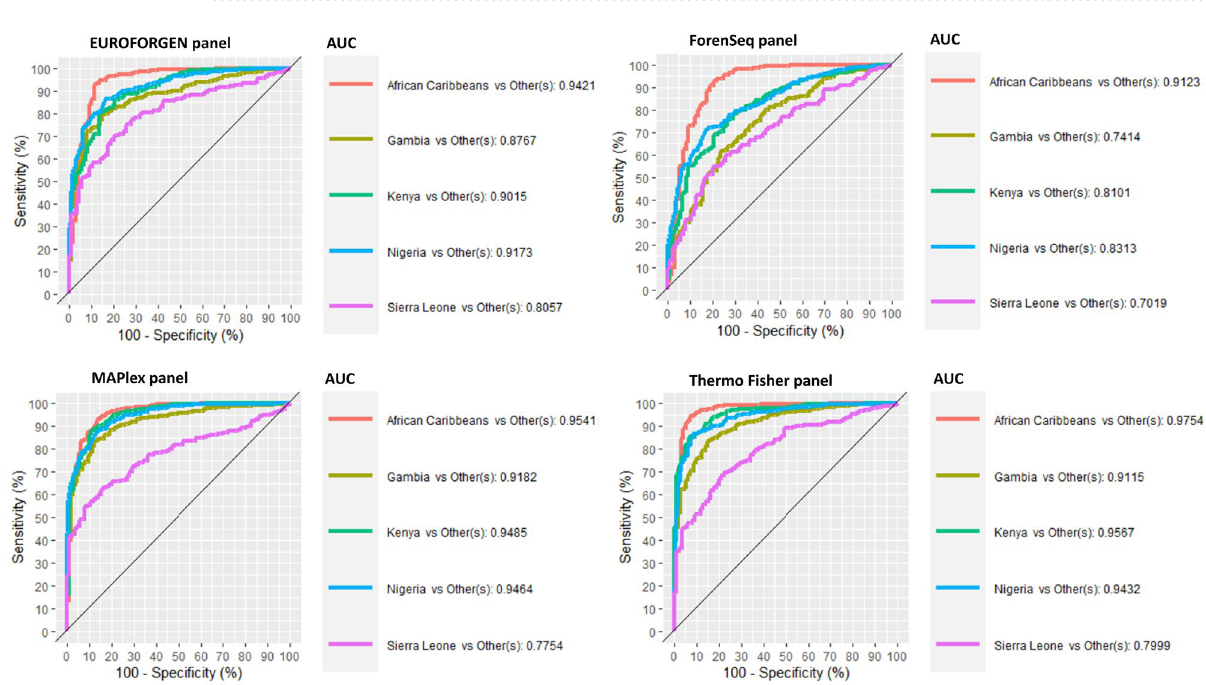
Figure 7. ROC curves, sensitivity, specificity, and AUC values for African countries and